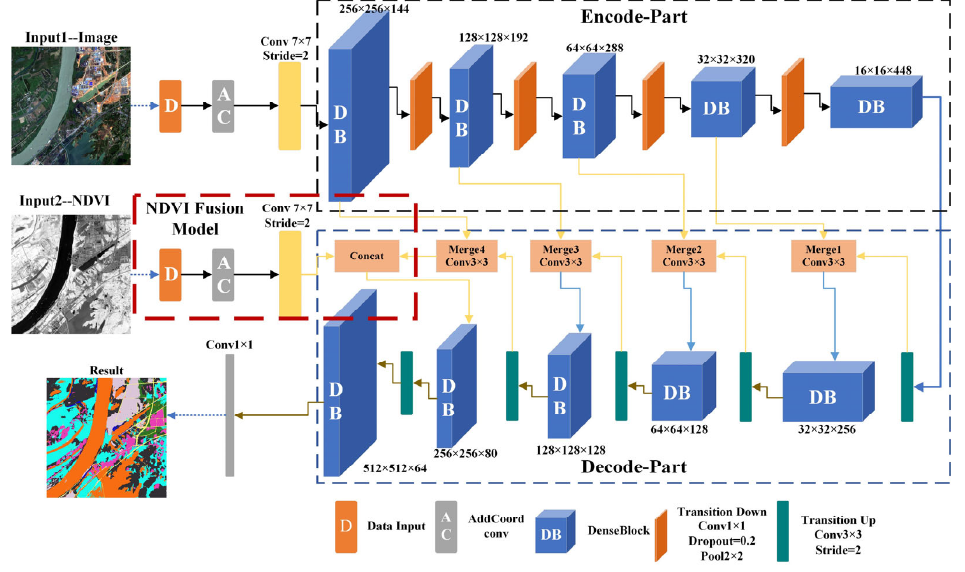
Figure 1. Architecture of